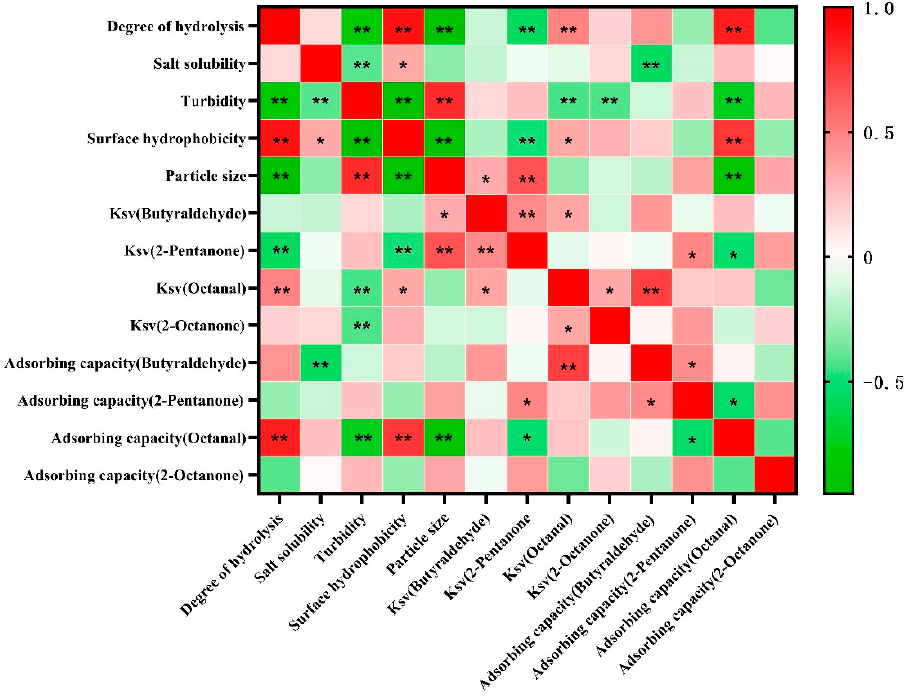
Figure 6. Heat map of the correlation analysis among degree of hydrolysis (DH) physicochemical properties, and K sv . The red color represents positive correlations and green indicates negative correlations. The significance is indicated as * p < 0.05; ** p < 0.01.